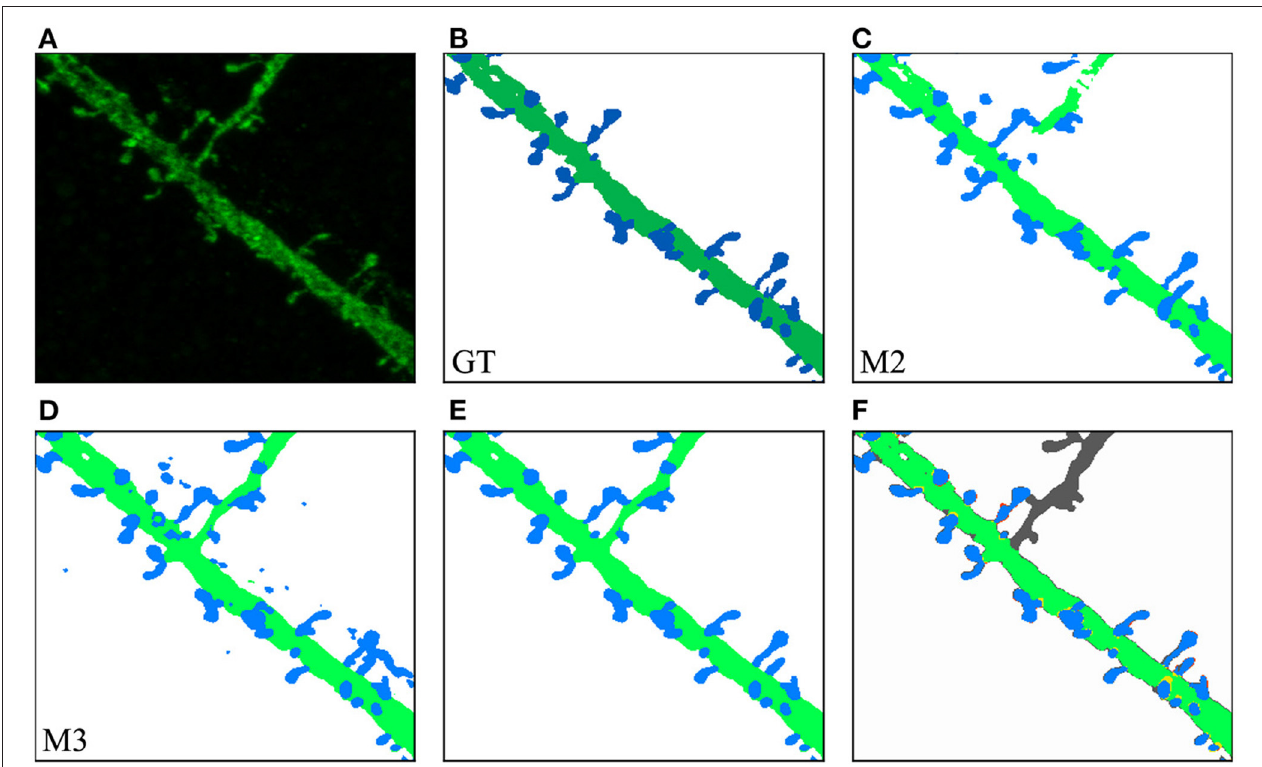
FIGURE 11 | Second case study: (A) an ROI selected by the user from the original confocal image; (B) GT segmented dendritic shafts and spines (note that the collateral branch was not originally selected for reconstruction); (C) M2 produced insufficient quality results segmenting some structures; (D) M3 performed better but introduced noise; (E) removed noise, the segmented structures in the GT (B) were properly segmented; (F) compares the GT with M3 results after noise removal, showing matched dendritic shafts (bright green) and spines (bright blue), structures missing in GT (gray), structures missing in M3 (red), and misclassifications